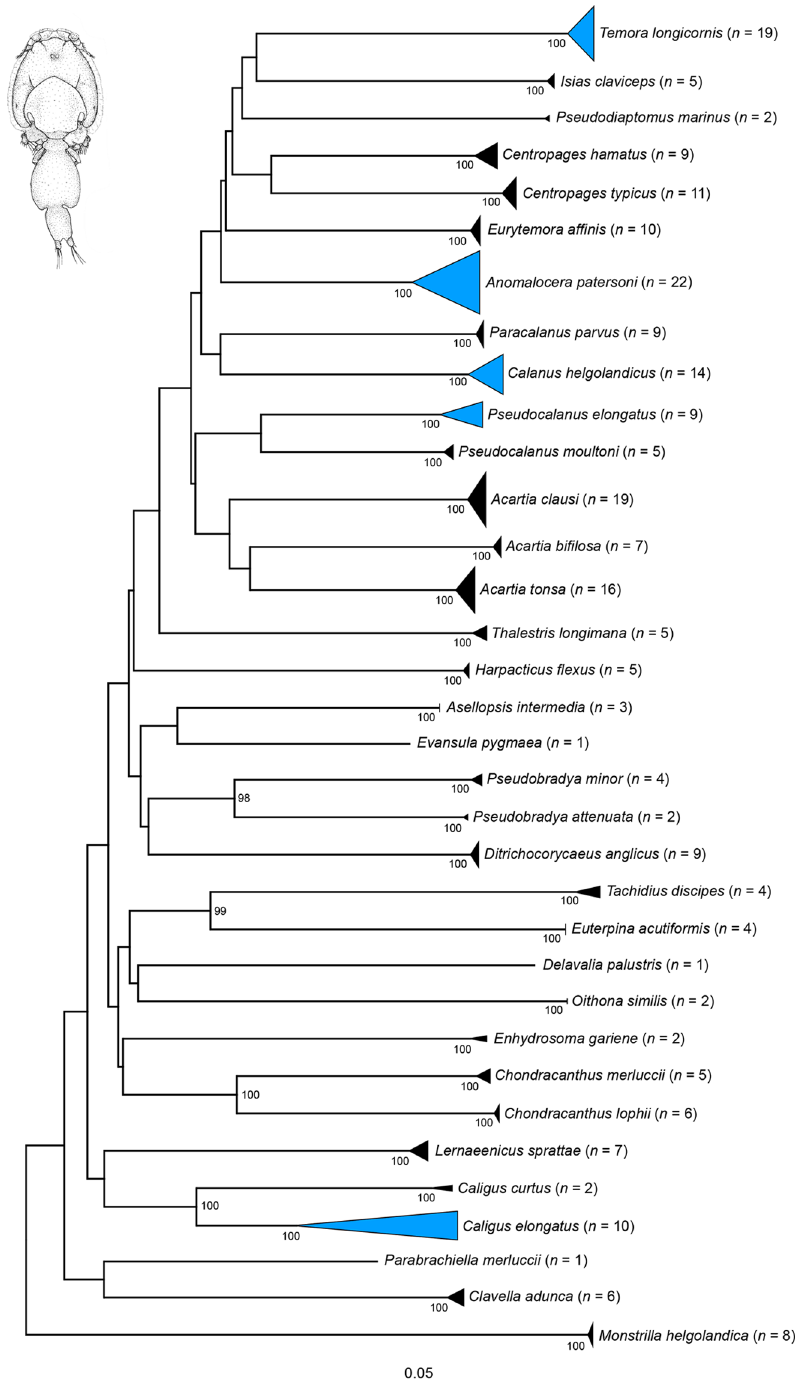
Fig 1. Neighbor joining topology of the analyzed Copepoda based on Kimura 2-parameter distances. The number of analyzed specimens collapsed into a single node is provided following the species name. Triangles indicate the relative number of individual ’ s sampled (height) and sequence divergence (width). Blue triangles indicate species with intraspecific maximum pairwise distances > 2.2%. Numbers next to nodes represent non-parametric bootstrap values > 90% (1,000 replicates). Drawing of Caligus curtus O.F. Müller, 1789 is taken and modified from a previous publication